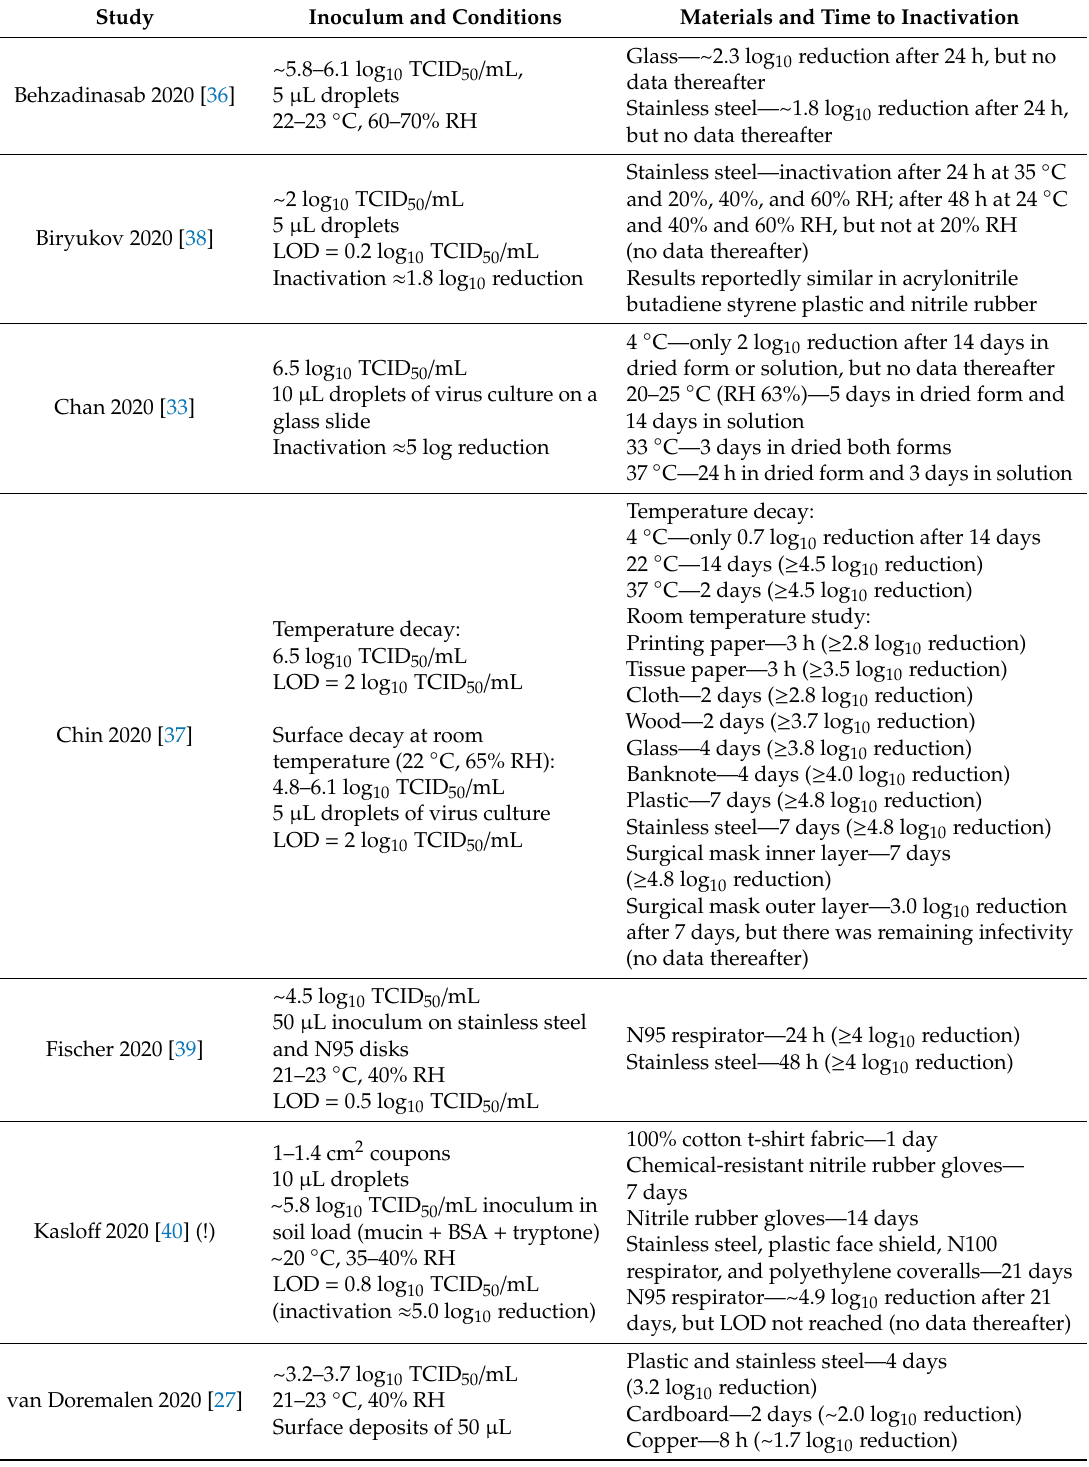
Table 3. Studies reporting on the viability of